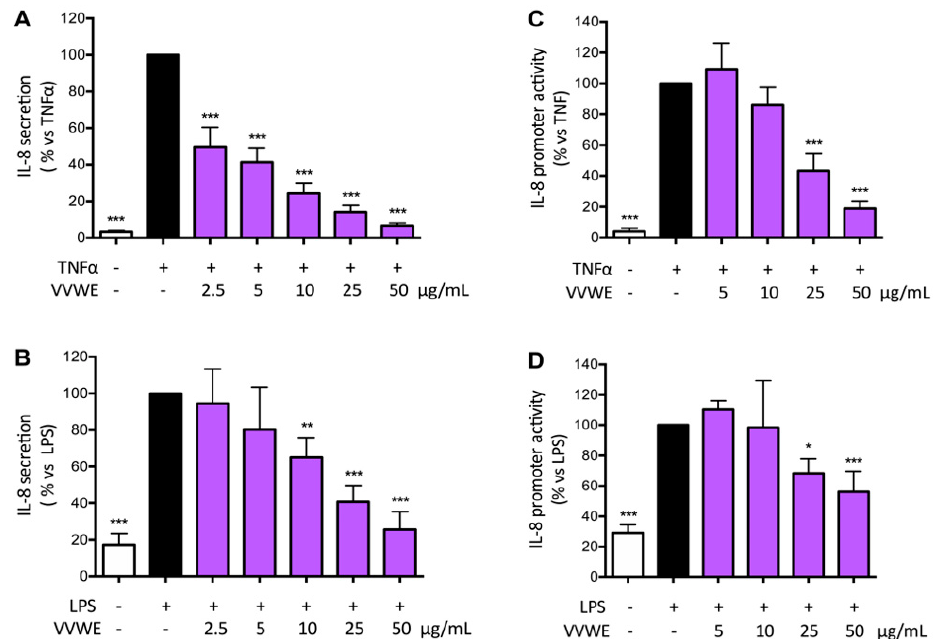
Figure 1. E ff ect of water extract from Vitis vinifera leaves (VVWE) on the tumor necrosis factor- α (TNF- α )-induced ( A ) or lipopolysaccharide (LPS)-induced ( B ) interleukin-8 (IL-8) secretion. HaCaT cells were treated for 6 h with TNF- α (10 ng / mL) or LPS (5 µ g / mL) and VVWE (2.5–50 µ g / mL). IL-8 secretion was evaluated by ELISA assay. Basal (without pro-inflammatory stimuli) and control (with TNF- α / LPS) levels of IL-8 were 17.4, 560.1 and 108.7 pg / mL, respectively. The e ff ect of VVWE was evaluated on IL-8 promoter activity induced by TNF- α ( C ) and LPS ( D ). HaCaT cells were treated for 6 h with TNF- α (10 ng / mL) or LPS (5 µ g / mL) and VVWE (5–50 µ g / mL). IL-8 promoter activity was measured in transfected HaCaT cells by the luciferase assay. The graphs show the means ± SD of at least three experiments performed in triplicate. Statistical analysis: one-way ANOVA, followed by Bonferroni’s post hoc test. * p < 0.05, ** p < 0.01, *** p < 0.001 vs. TNF- α alone. Epigallocatechin-3-gallate (EGCG) (20 µ M) was used as the reference inhibitor of TNF- α or LPS-induced IL-8 secretion (62.1% and 84.9% inhibition, respectively) and IL-8 promoter activity (35.9% and 33.3% inhibition,